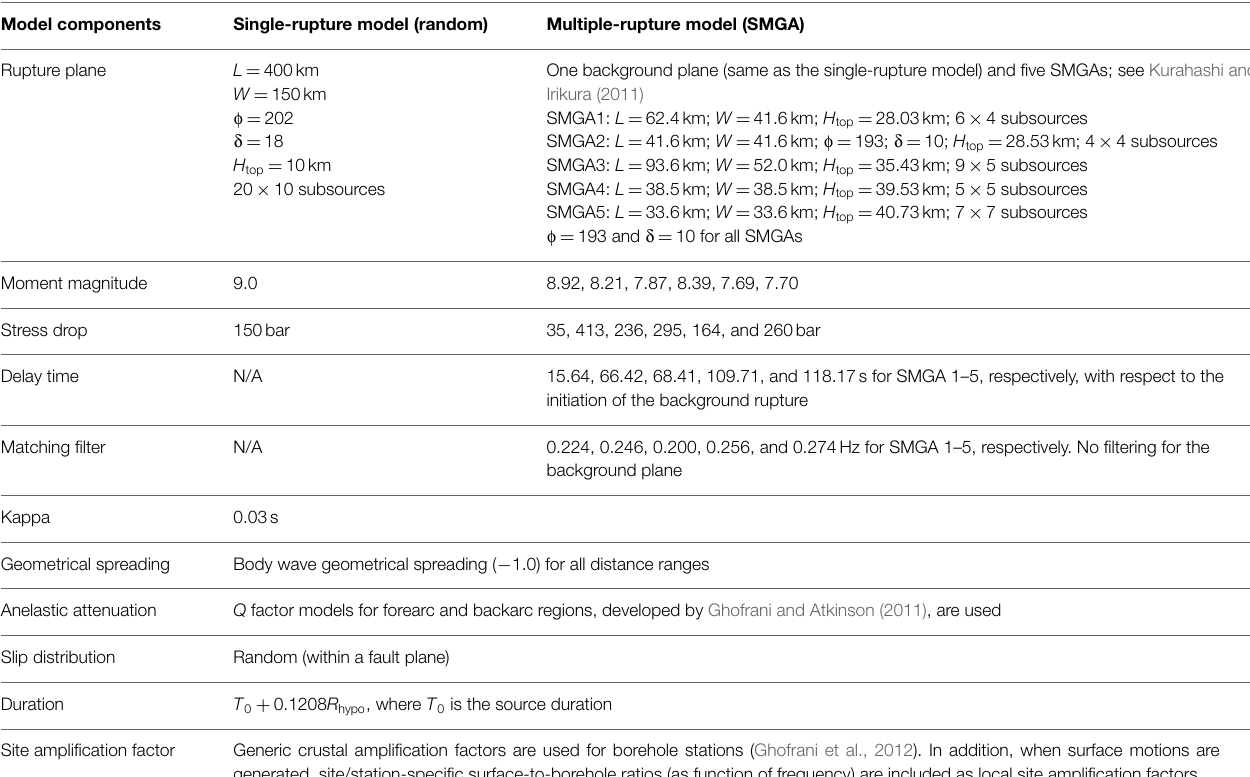
TABLE 1 | Input parameters of Tohoku-EXSIM simulations (Ghofrani et al.,